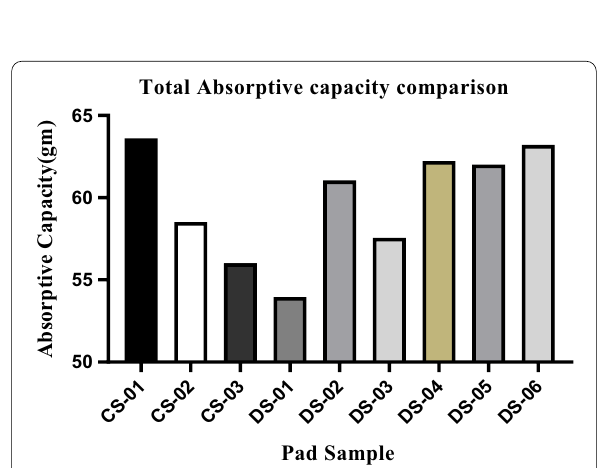
Fig. 7 Total absorptive capacity of various samples